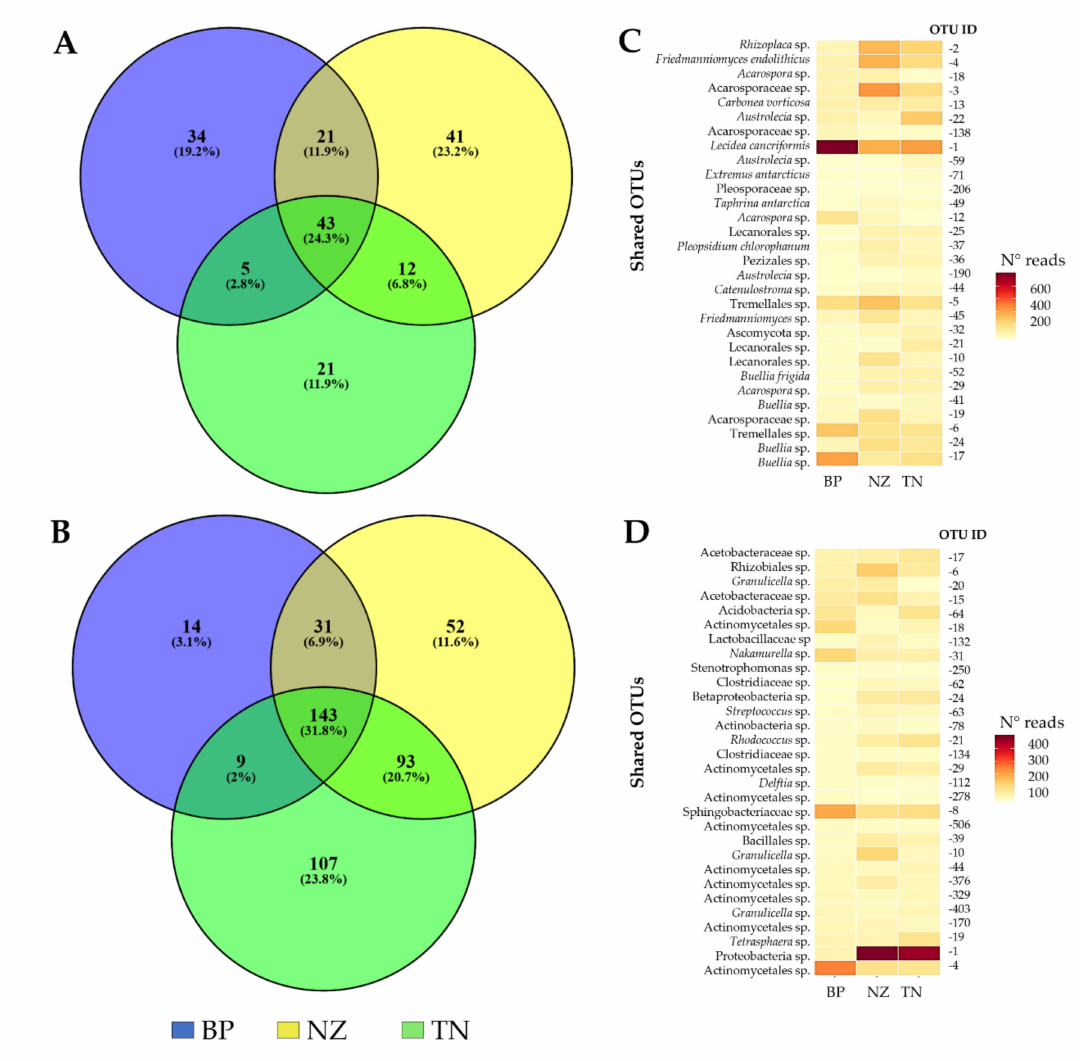
Figure 4. ( A , B ) Venn diagrams reporting the distribution of fungal ( A ) and bacterial ( B ) OTUs among the three localities studied. Percentages of both shared and unique OTUs are shown in